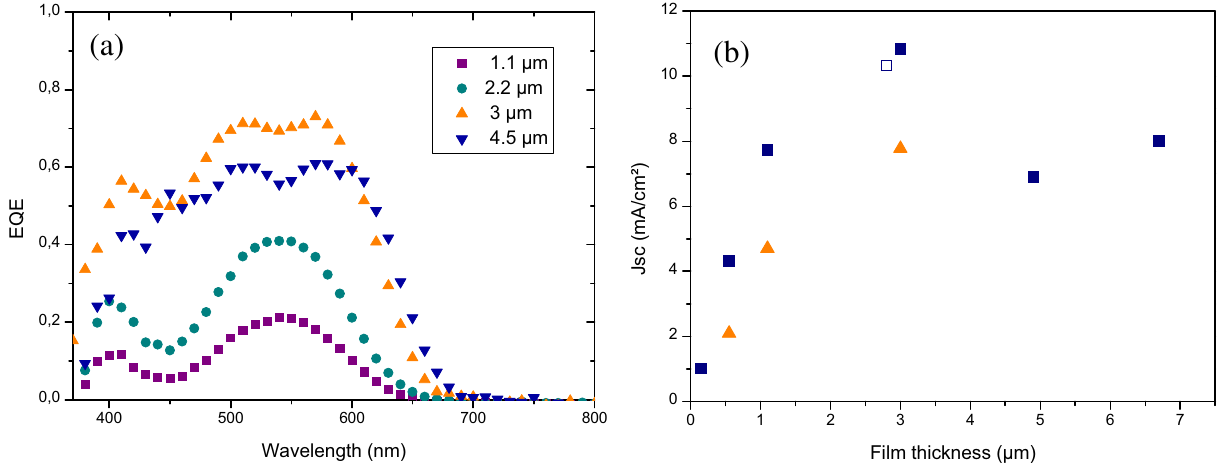
Fig. 7. (a) Spectral response of dye-sensitized solar cells based on nanoporous ZnO grown on ZnO:Al of increasing thicknesses and dyed with D149 for 2 h. (b) Evolution of the Jsc measured with the solar simulator (squares) and calculated from the spectral response (triangles) with the thickness of the nanoporous ZnO in the same coloration conditions. Jsc of the best cell is shown (empty